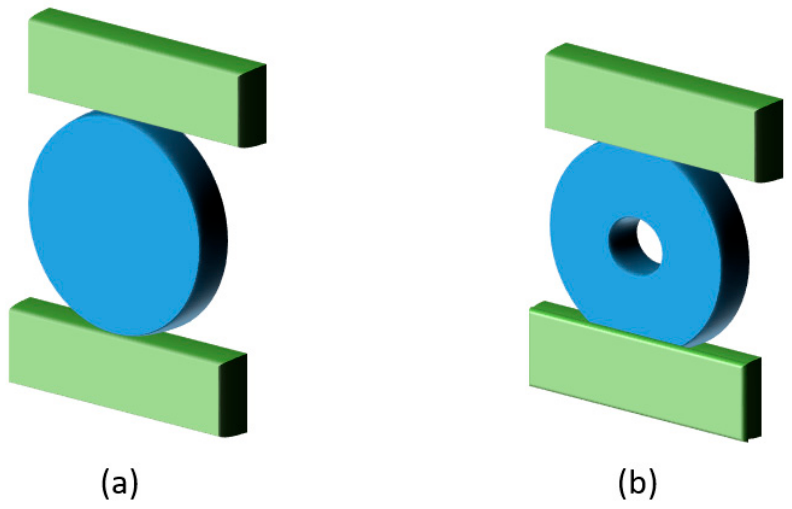
Figure 3. A disk specimen configuration used for ( a ) conventional Brazilian tests and ( b ) modified Brazilian tests.